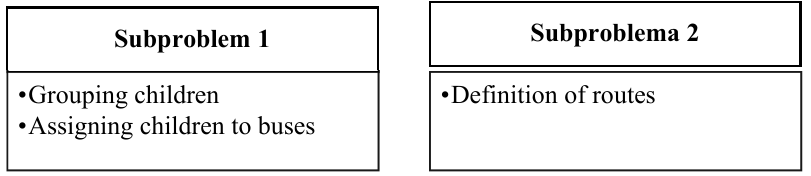
Fig. 2. Subproblems of the school bus routing